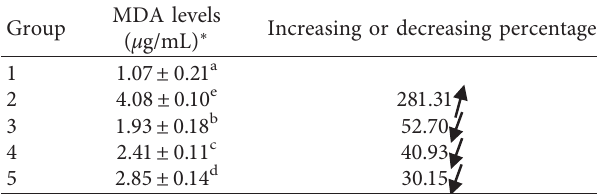
Table 1: MDA levels on the rats’